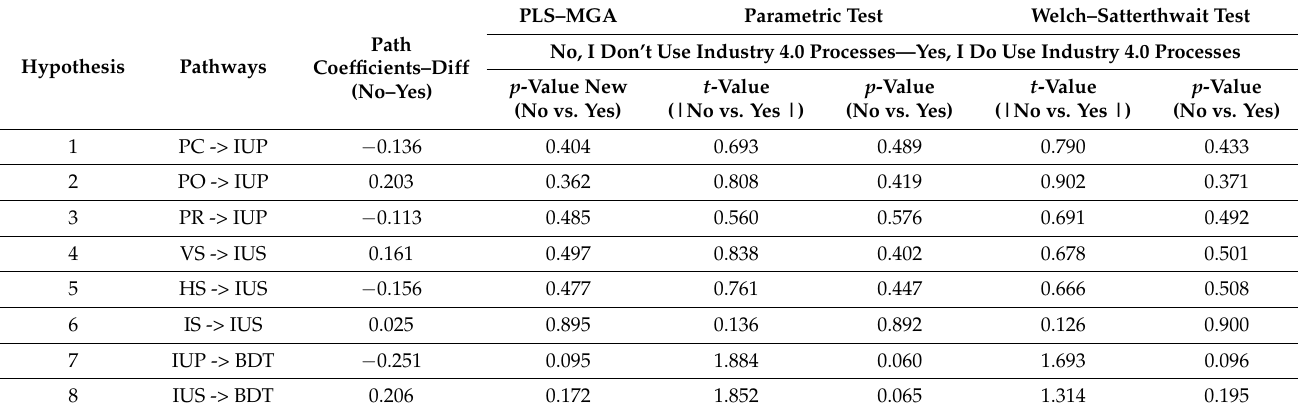
Table 6. Differences between groups “No, I don’t use Industry 4.0 processes” and “Yes, I do use Industry 4.0 processes”.